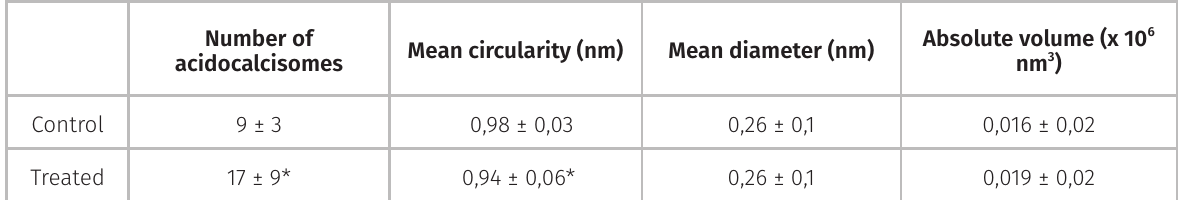
Table II. Numerical and circular changes in acidocalcisomes of L. amazonensis promastigotes grown in the for 72 hours. The (*) represent statistically significant presence of the extract IC 50